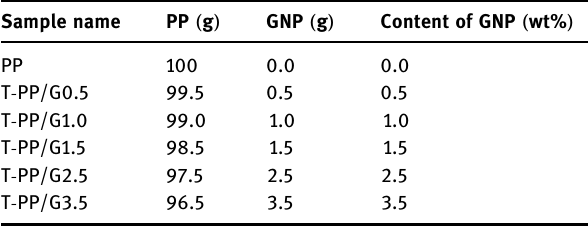
Table A1: Name and composition of samples Table A2: Tensile mechanical properties of neat PP and composites